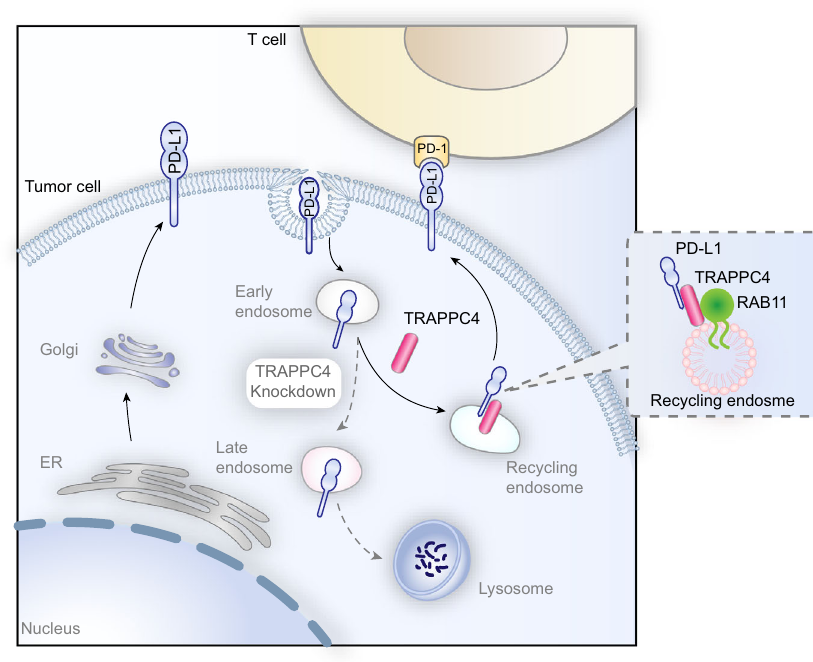
Fig. 7 TRAPPC4 maintains the expression of PD-L1 by regulating its intracellular traf fi cking. In the tumor cell cytoplasm, TRAPPC4 acts as a scaffold for endocytosed PD-L1 and RAB11, thus facilitating the RAB11-mediated recycling of PD-L1 and restoring the distribution of PD-L1 on the cell surface. Disruption of TRAPPC4 in CRC cells leads to a redistribution of endocytosed PD-L1 to lysosomes and its degradation, resulting in enhanced T-cell-mediated cytotoxicity toward colorectal tumor